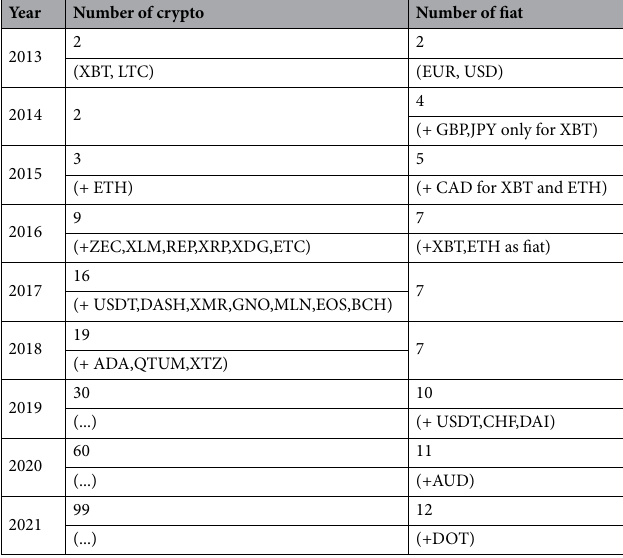
Table 2. Number of cryptocoins and fiat available on Kraken during years. At the beginning of the launch of the Kraken platform, there were available only two cryptos (Bitcoin as XBT and Litecoin as LTC) traded using 2 fiat (Euro and Dollar, using EUR and USD as corresponding tickers). As far as the platform grow up, there were listed more cryptos and fiat, up to 2021 when there are more than 90 cryptos available, and traded using 12 fiat. Since 2016, Bitcoin and Ethereum were also used as “fiat”, to simplify the process of buying and